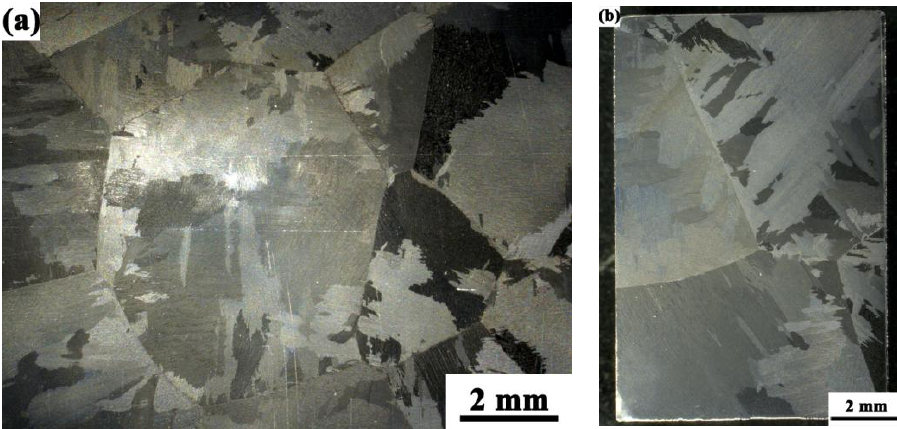
Figure 2. Macro structure of the undeformed sample: ( a ) top surface and ( b ) transverse section.